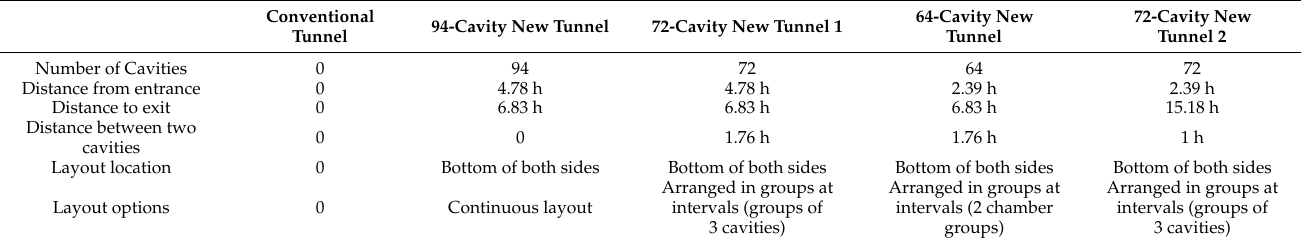
Table 1. Helmholtz resonator module